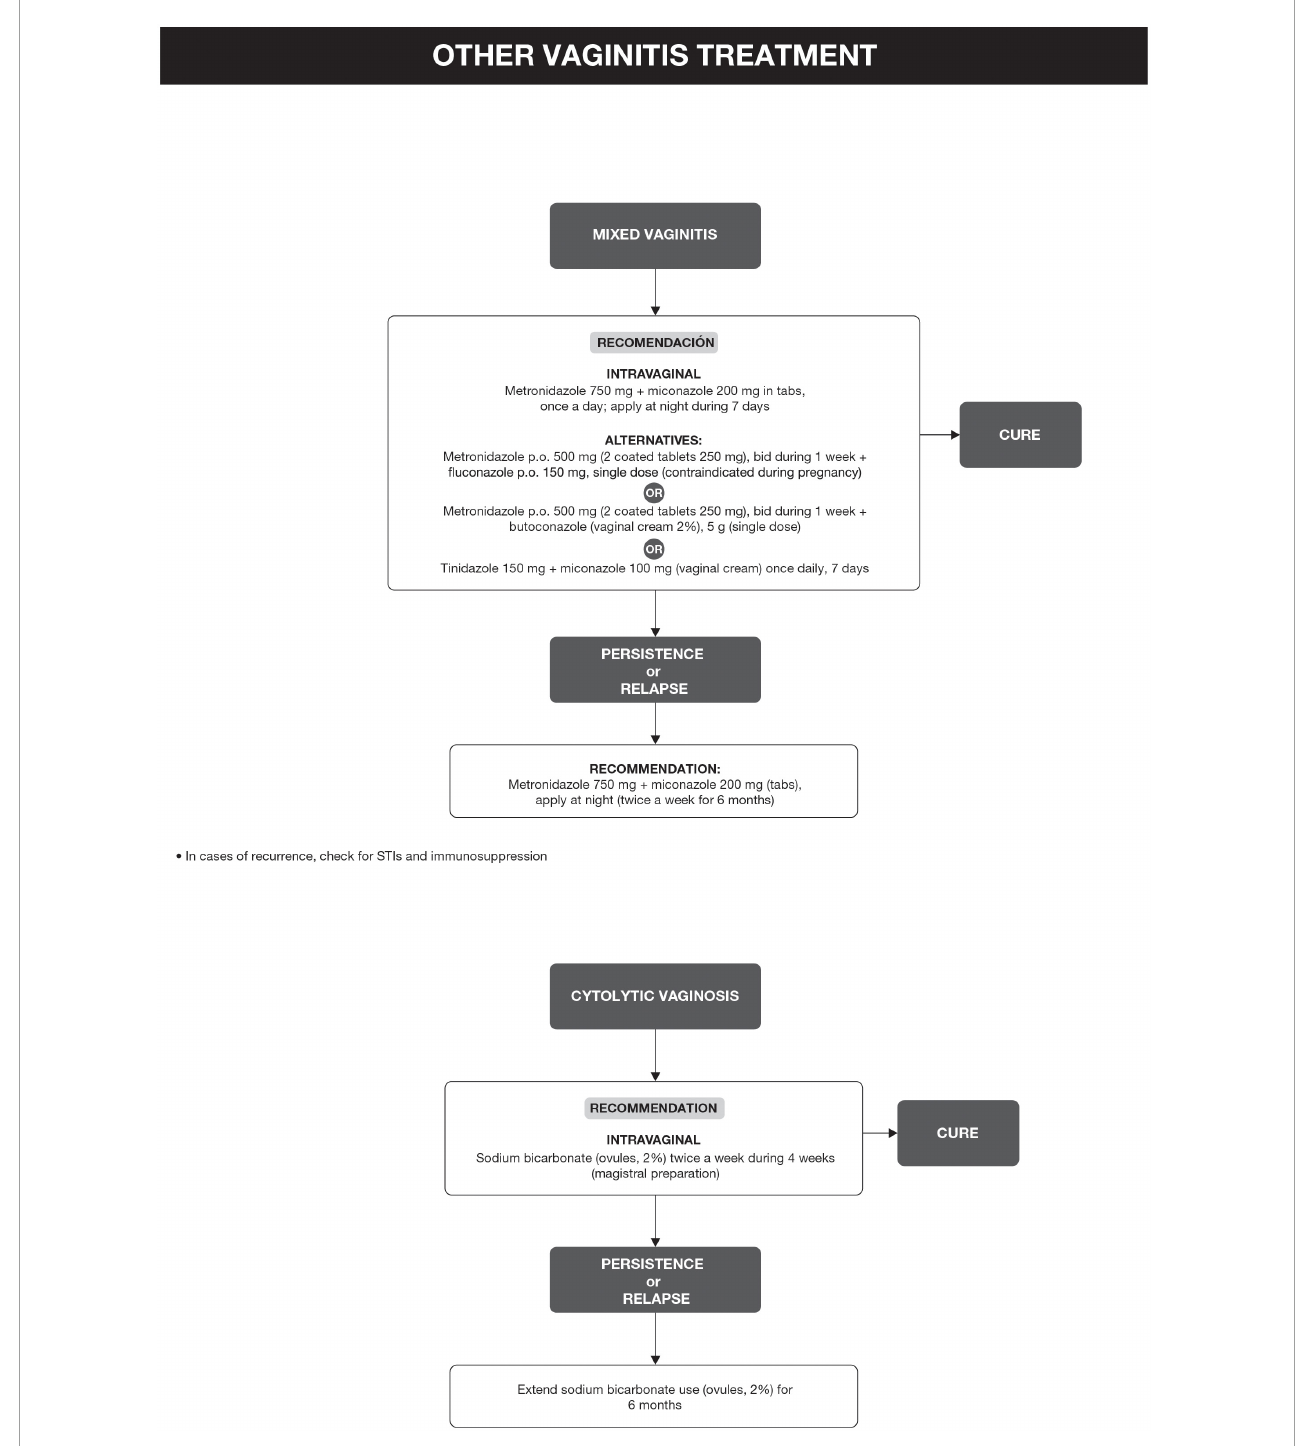
FIGURE5 Other vaginitis